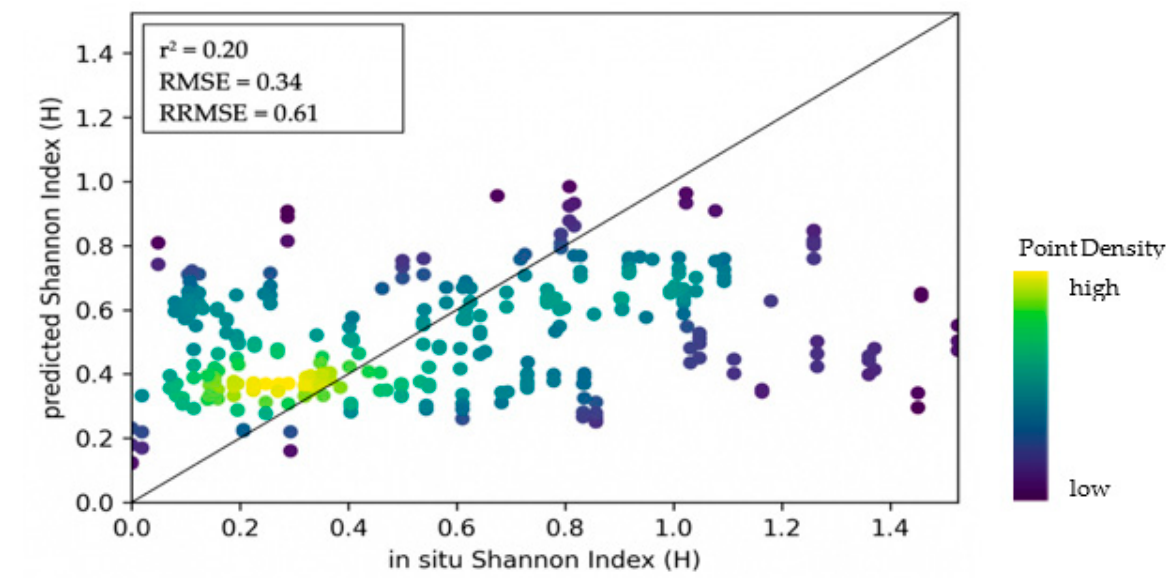
Figure 12. Density scatterplot showing the relationship between predictions of tree species diversity (Shannon Wiener Index) and in situ values based on the EVI texture model.